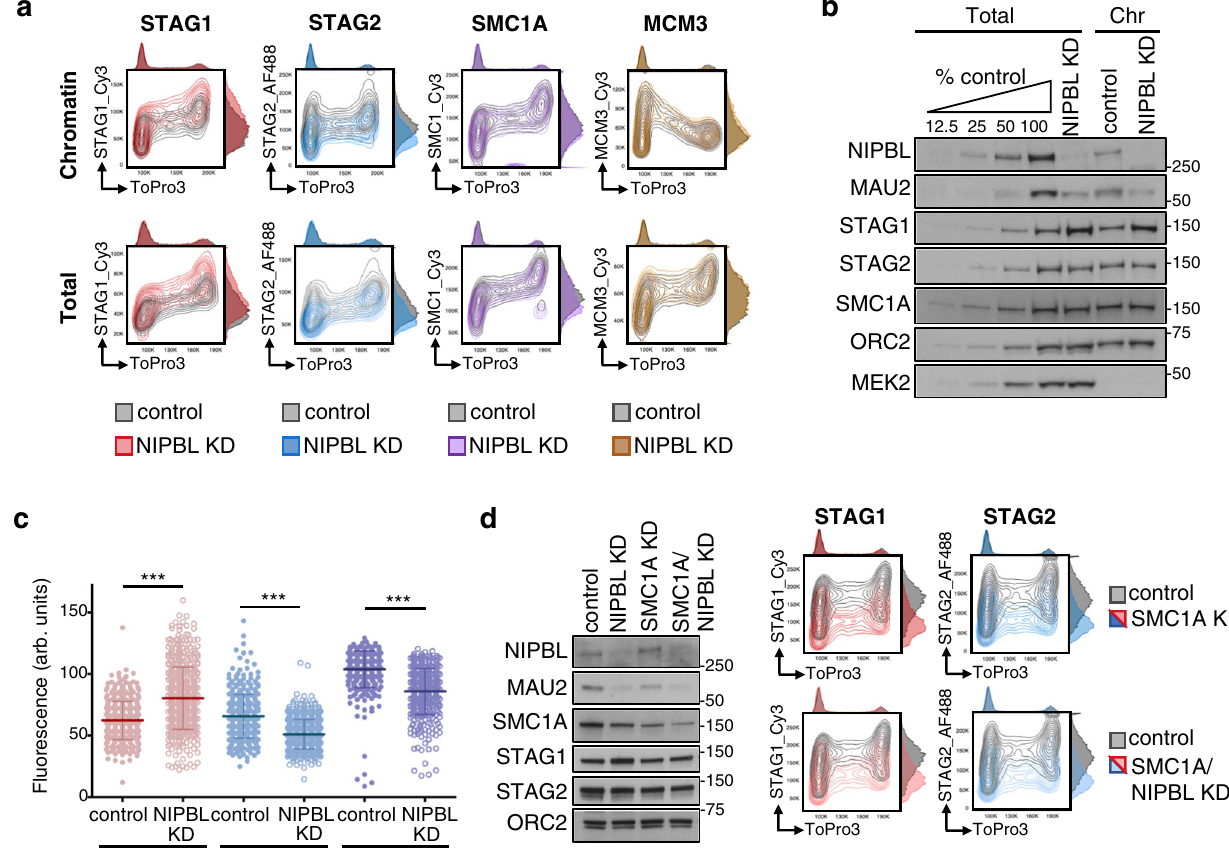
Fig. 1 | NIPBL KD affects cohesin-STAG1 and cohesin-STAG2 in opposite ways. a Asynchronously growing HeLa cells mock transfected (control) or transfected with siRNA against NIPBL (NIPBL KD) were analyzed by fl ow cytometry 72h later. Contour plots of the indicated proteins in control (gray plots) and NIPBL KD cells (colored plots) were overlapped for comparison. For each map, the cell cycle pro fi leaccordingtoDNAcontentappearsontopwhilethedistributionofantibody intensities is plotted on the right. b Immunoblot analysis of chromatin fractions (Chr)andtotalcellextractsfromcontrolandNIPBLKDcells.Increasingamountsof total extract from control cells were loaded to better quantitate the extent of depletion. NIPBL partner MAU2 also decreases after NIPBL KD. This is one